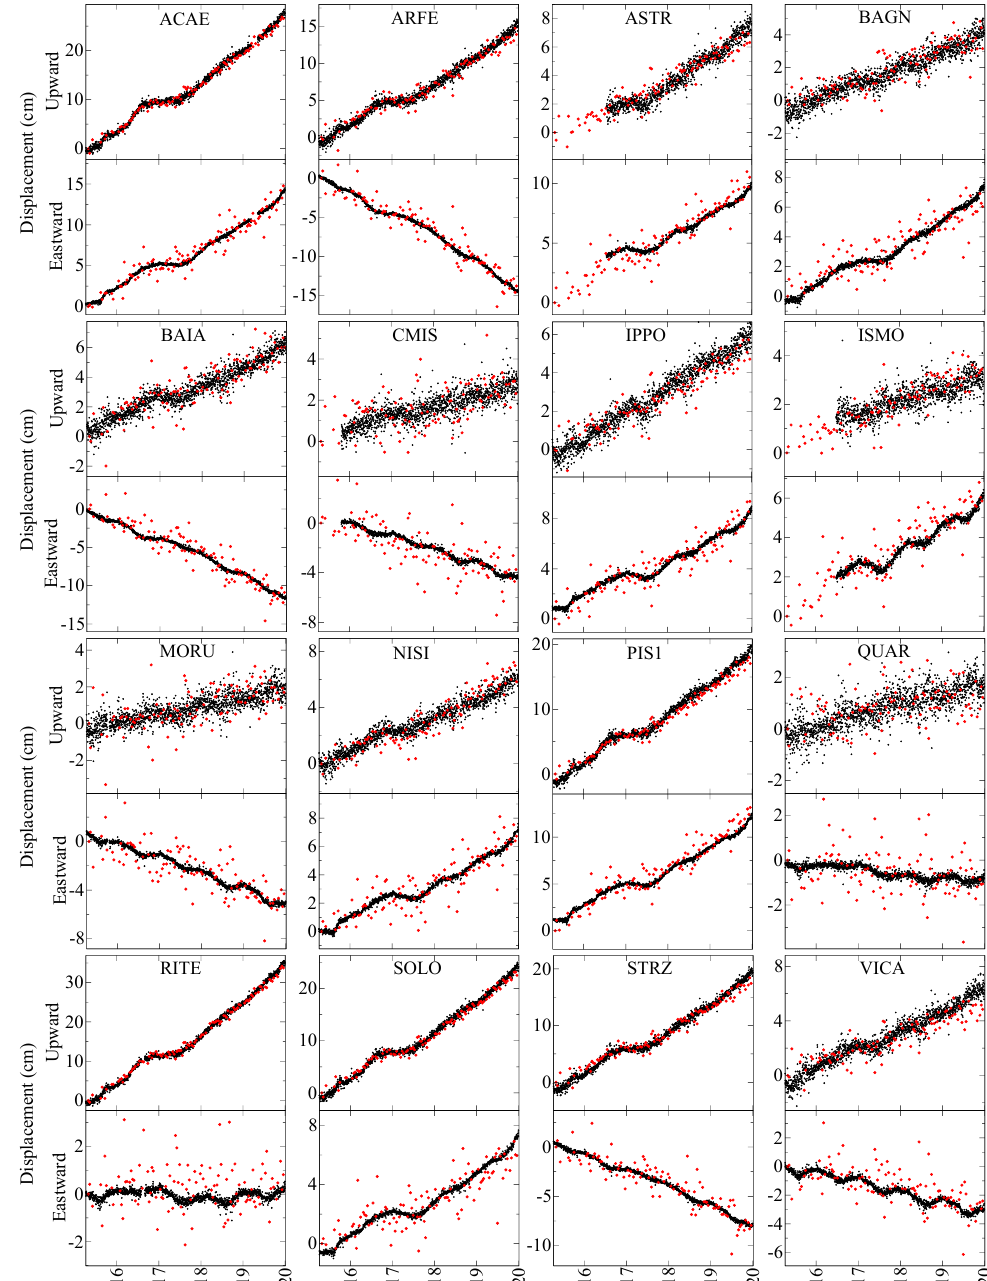
Figure 5. Comparison between GPS and Sentinel-1A SAR vertical and eastward displacements for the GPS stations within the dashed black circle in Figure 1. GPS displacements (black dots) are referred to MAFE (see Figure 1); SAR displacements (red dots) are referred to the median value within a circular area, 200 m in radius, centered on